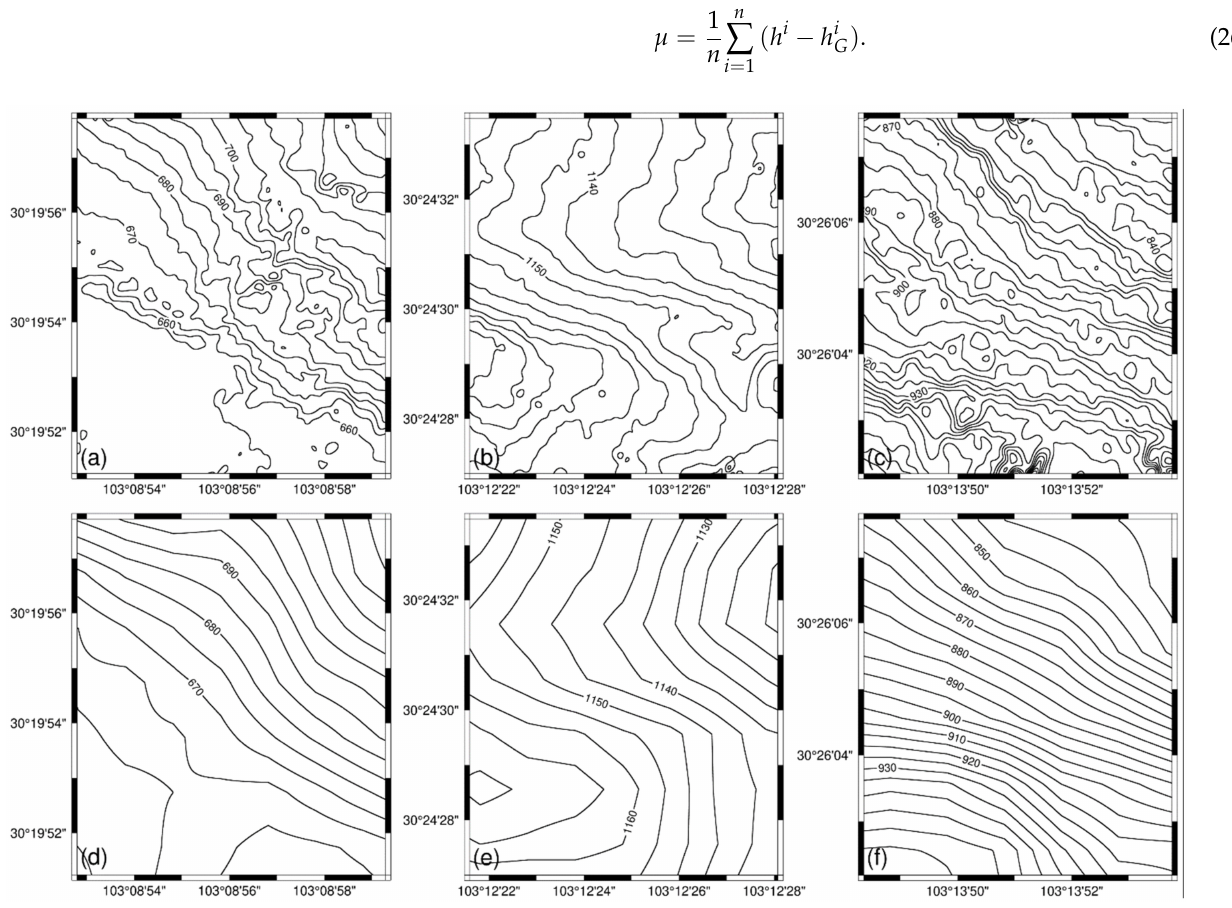
Figure 15. Contours of the windowed areas marked in Figure 11 from the obtained DSM (top) and